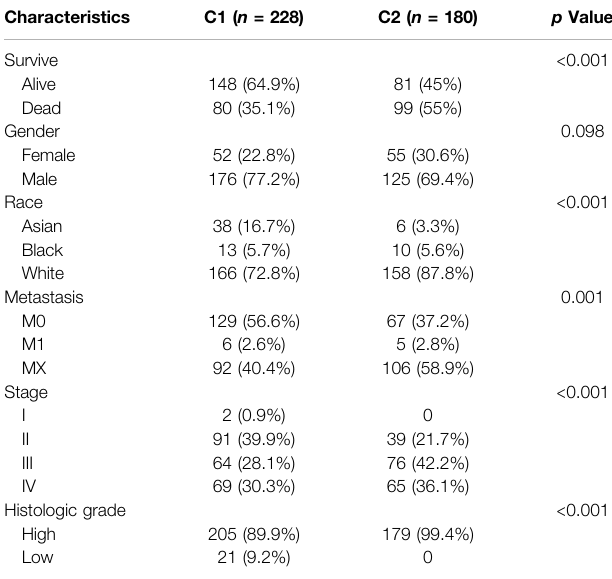
TABLE 1 | Clinicopathological feathers between the two clusters identi fi ed by energy metabolic-related gene set.